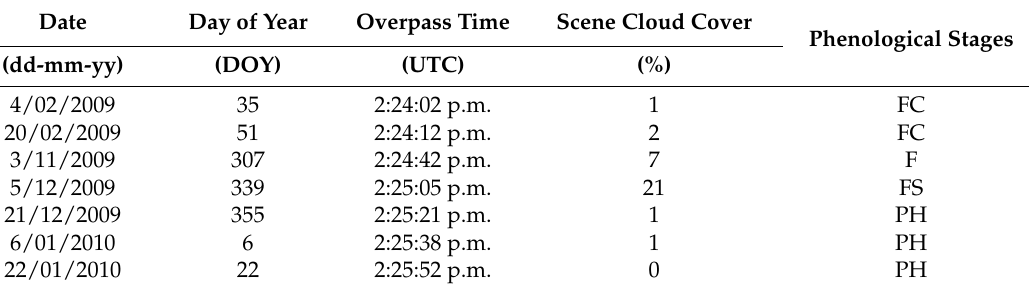
Table 1. Images selected for processing the Shuttleworth and Wallace model (SW) and main phenological stages of a drip-irrigated olive